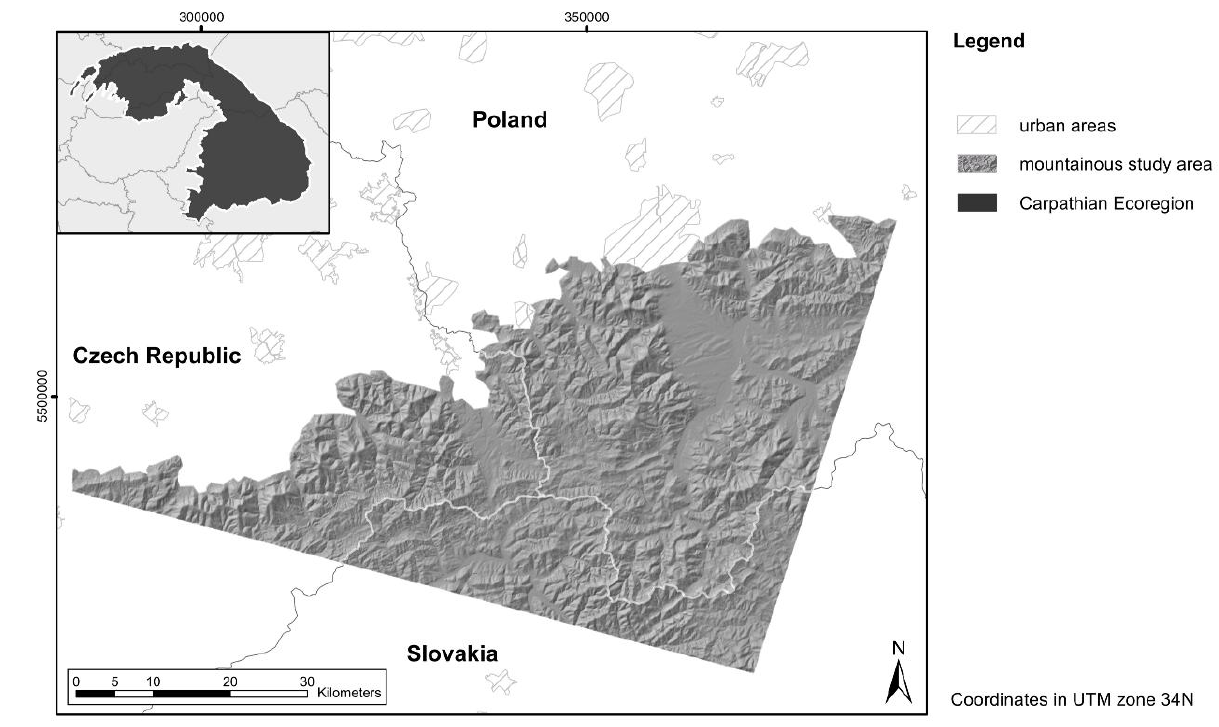
Figure 1. Study area within the Carpathian Mountains in the border region of Poland, the Czech Republic and